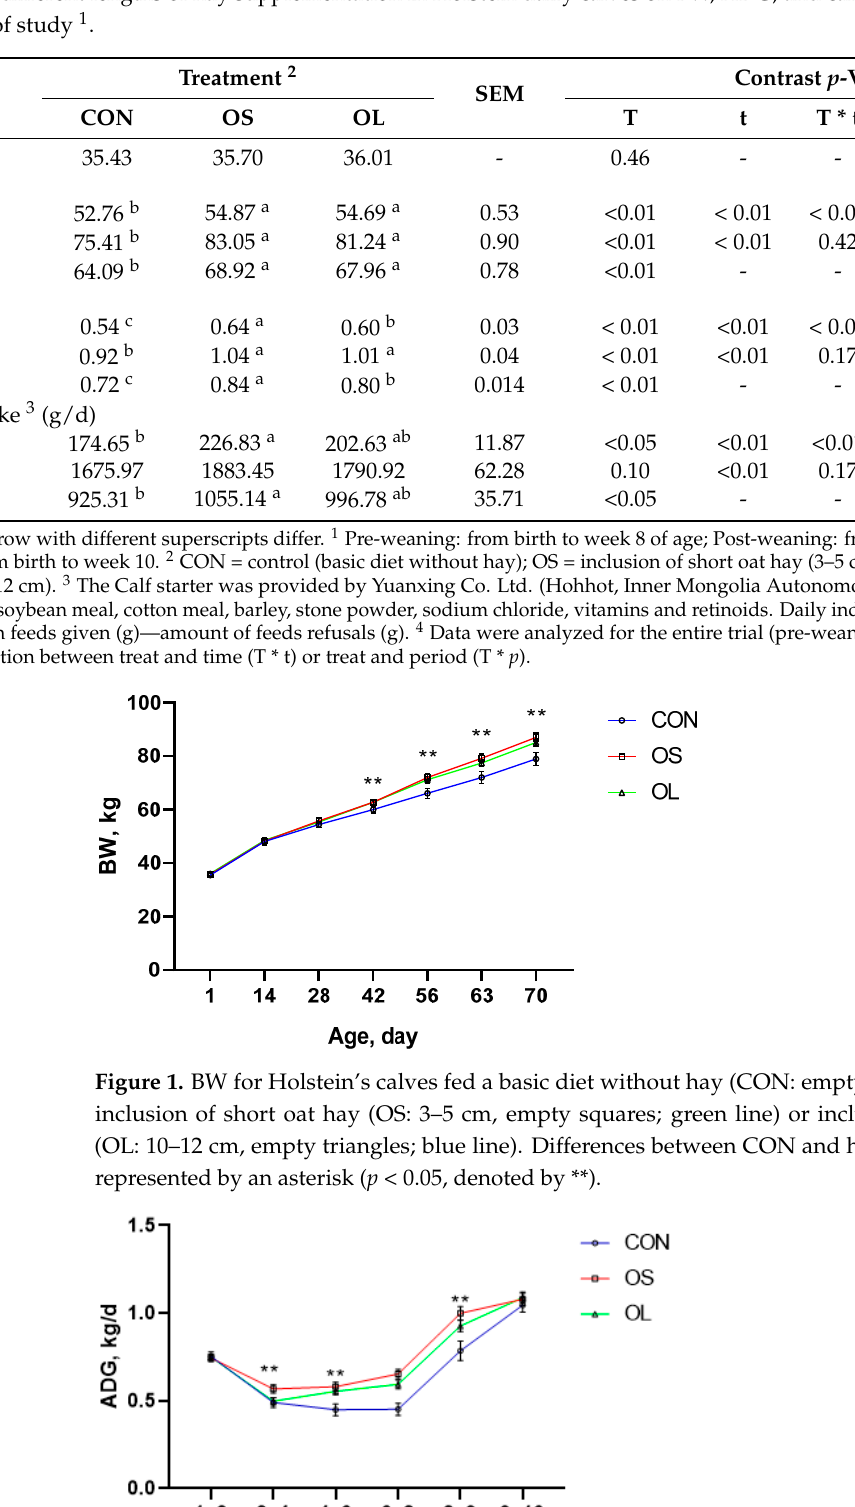
Figure 3. Calf starter intake for Holstein female calves fed a basic diet without hay (CON: empty circles; red line) and inclusion of short oat hay (OS: 3–5 cm, empty squares; green line) or inclusion of long oat hay (OL: 10–12 cm, empty triangles; blue line). Differences between CON with hay are represented by an asterisk ( p < 0.05, denoted by **). Differences between OS with OL are represented by a cross ( p < 0.05, denoted by ☨ ). 2.2. Body Growth Parameters Data of body structural measurements (height, body length, heart girth, abdominal girth, circumference of cannon bone) are presented in Table 2. Hay treatments did not influence body height and circumference of cannon bone during the three-time periods (pre-weaning, days 1–56; post-weaning, days 57–70 and entire trial, days 1–70). No differ- ences were observed for body length and heart girth during the pre-weaning period. However, body length ( p < 0.01) and heart girth ( p < 0.05) in calves fed hay were greater